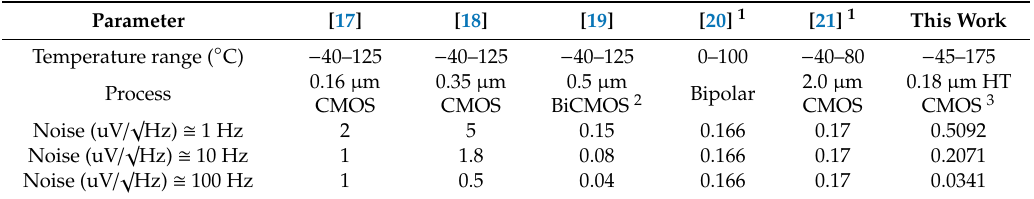
Table 1. Performance of Bandgaps.